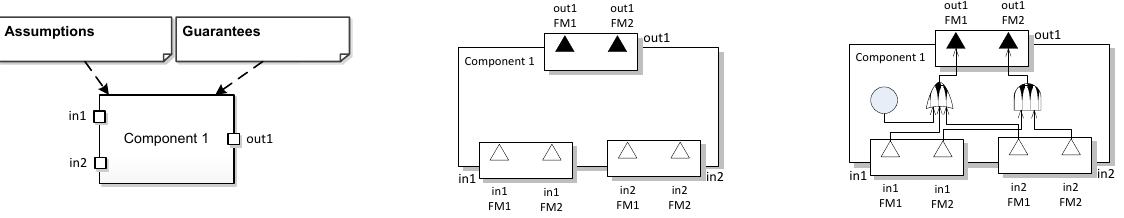
Figure 5. Transition from Component Model to CFT Frame, and insertion of CFT